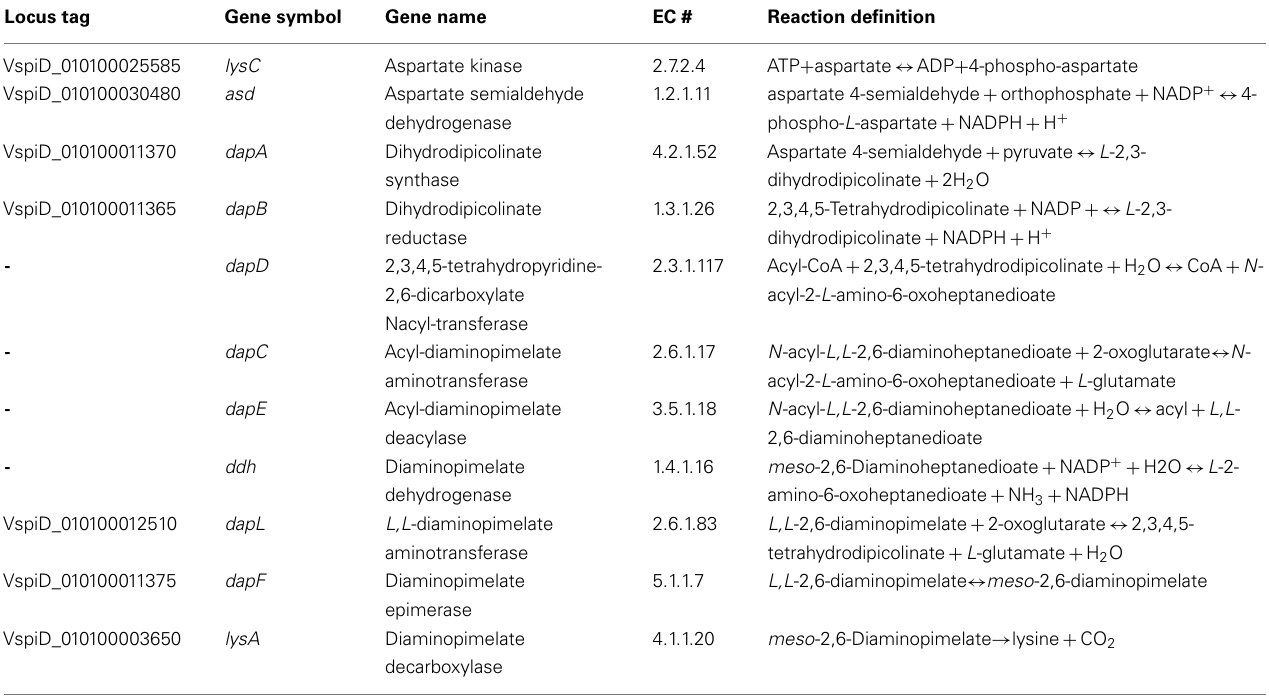
Table 1 | List of diaminopimelate/lysine biosynthesis genes from V. spinosum DSM 4136 T . Locus